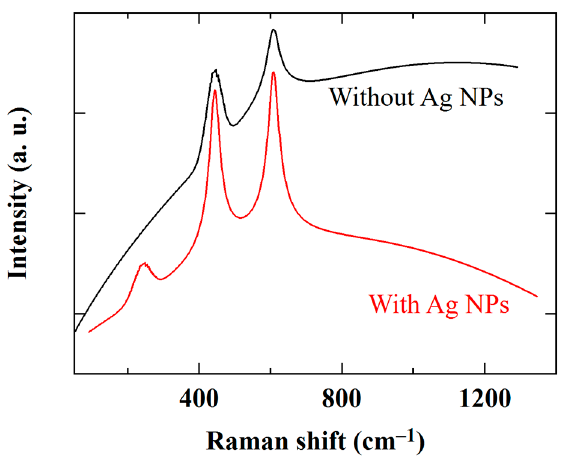
Figure 3. Raman spectrum of the ZnO precursor solution, without and with 10% Ag NPs.